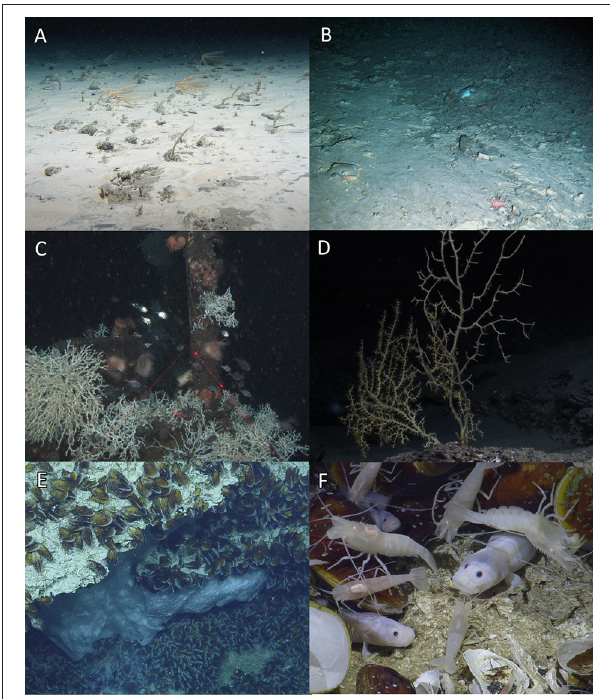
FIGURE 5 | Deep-sea communities near drilling activities. (A) Benthic communities shortly after smothering by (light colored) cuttings at the Tornado Field (1050m depth), Faroe-Shetland Channel, UK. (B) Edge of cuttings pile at the Laggan field, Faroe-Shetland Channel, UK (Figure 4D from Jones et al., 2012a). (C) Atlantic roughy, Hoplostethus occidentalis, among L. pertusa around the abandoned test-pile near Zinc at 450m depth in the Gulf of Mexico. Image courtesy of the Lophelia II program, US Bureau of Ocean Energy and Management and NOAA Office of Ocean Exploraiton and Research. (D) Appearance in 2013 of a Paramuricea biscaya colony damaged during the Deepwater Horizon oil spill in 2010. Image courtesy of ECOGIG, a GoMRI-funded research consortium and the Ocean Exploration Trust. (E,F) : Methane-seep communities from an area within the exclusive economic zone of Trinidad and Tobago that is targeted for future oil and gas development. The Ocean Exploration Trust is acknowledged for use of these photos from the E/V Nautilus 2014